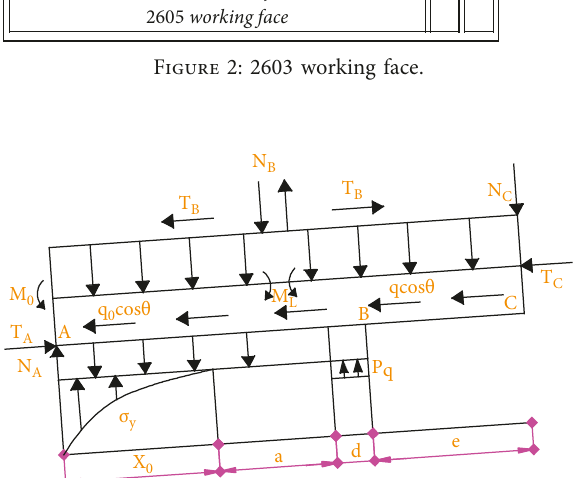
Figure 3: Mechanical model of goaf retaining